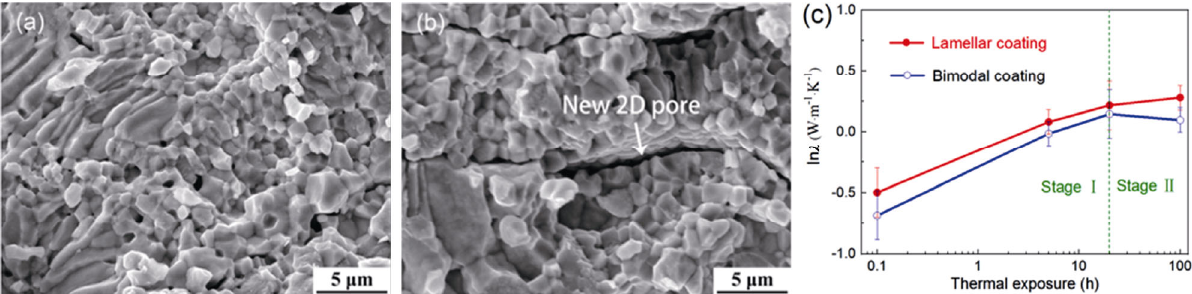
Fig. 64 Microstructure morphologies and thermal conductivities of the coatings: (a) morphologies of lamellae, (b) micro- lamella/nano-zone bimodal coatings that had been heat-treated at 1400 ℃ for 100 h, and (c) ln λ as a function of thermal exposure time. Reproduced with permission from Ref. [13], © ASM International 2018.